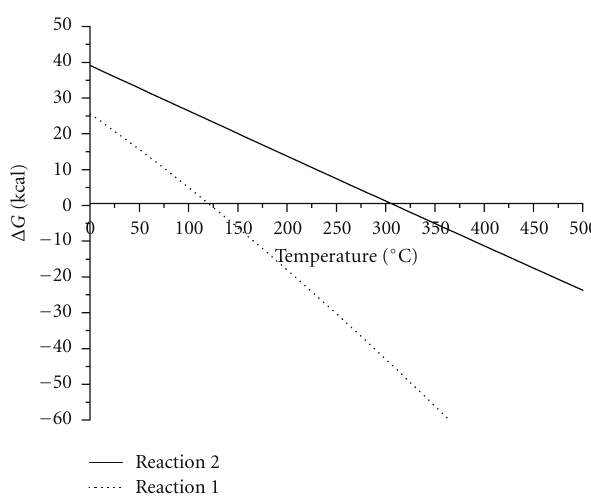
Figure 5: Energy formation Δ G analysis of cobalt nitrate de- shidratation and decomposition.